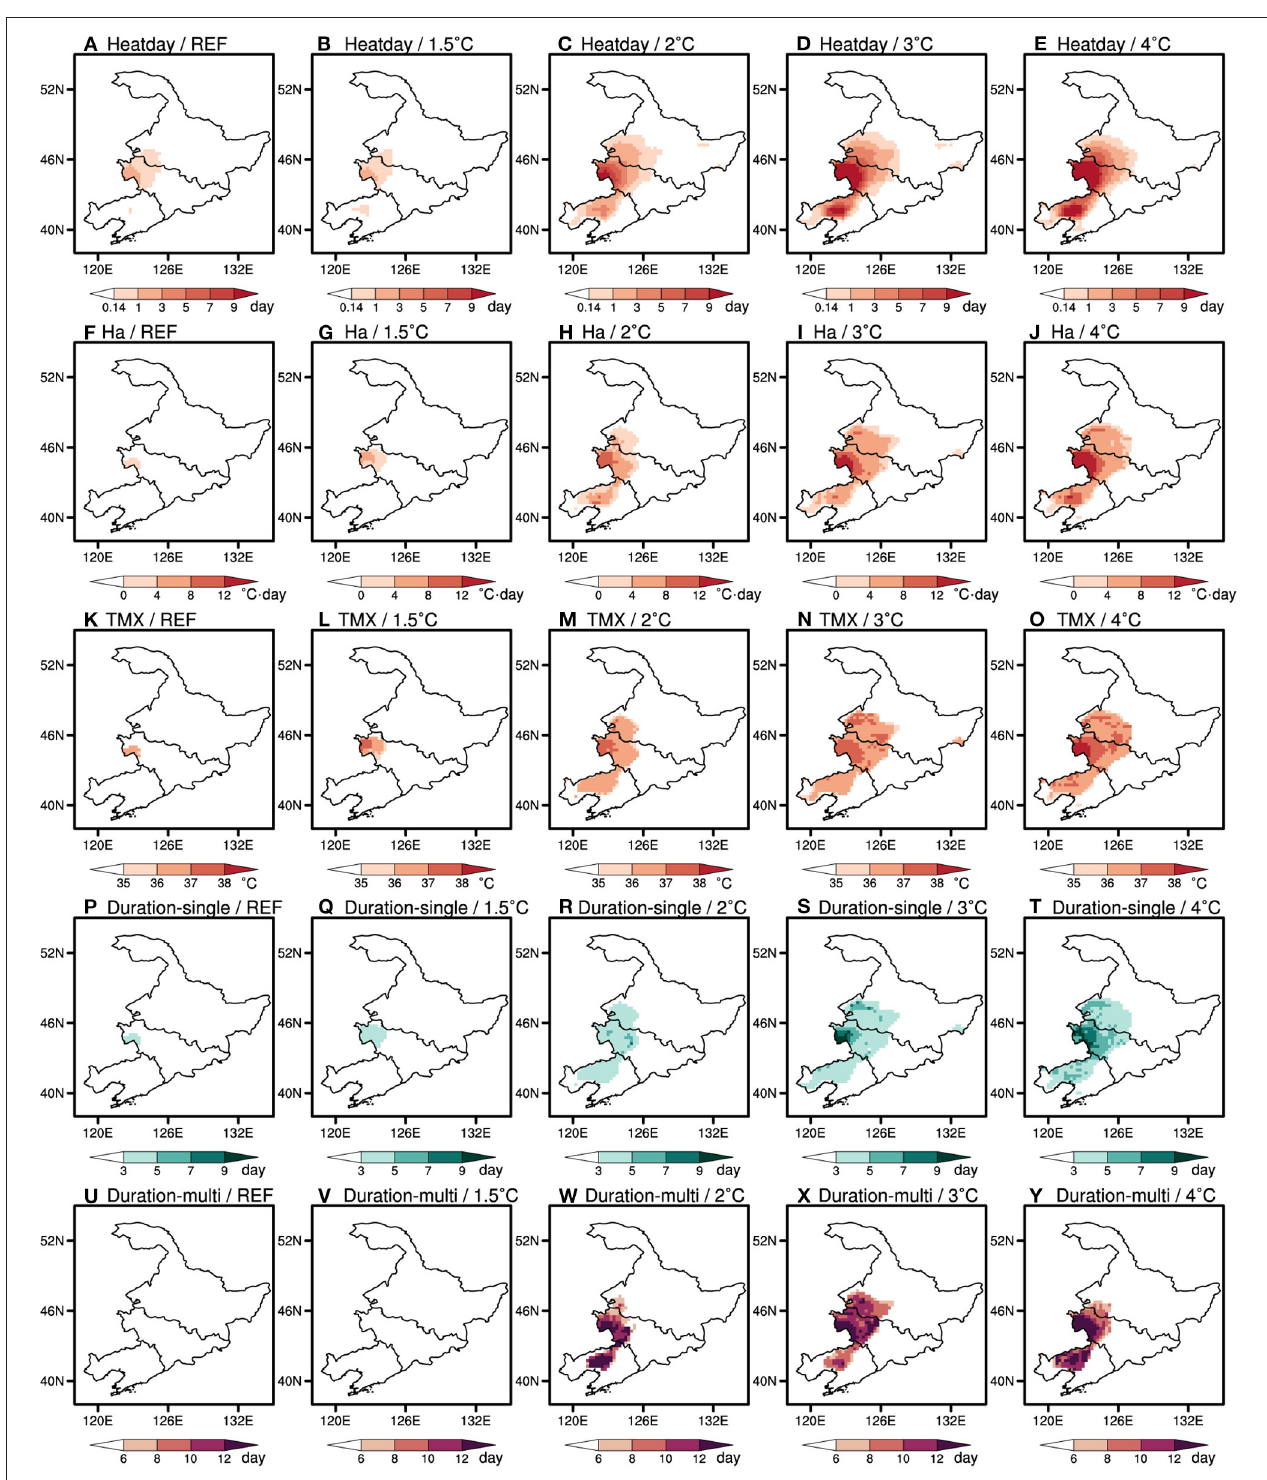
FIGURE 4 | Spatial distribution of (A–E) the number of high-temperature days (unit: day), (F–J) hazardous heat accumulation temperature (unit: ◦ C · day), (K–O) maximum temperature in the process of heat damage (unit: ◦ C), (P–T) single-process duration of heat damage (unit: day), and (U–Y) multiple-process duration of heat damage (unit: day) simulated (the first column) and projected by LMDZ-MME (the second to fifth columns) in Northeast China. The reference time period is 1986–2005. For future projection, the warming levels of 1.5, 2, 3, and 4 ◦ C are presented under the emission pathway of RCP8.5.